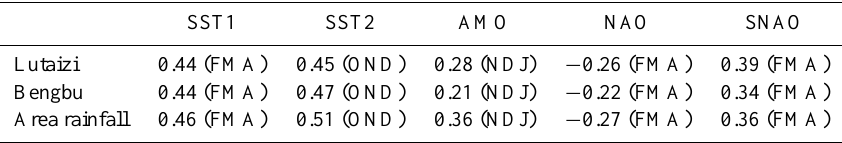
Table 2. The correlation between streamflow/area rainfall and climate predictors chosen in this study ∗ .